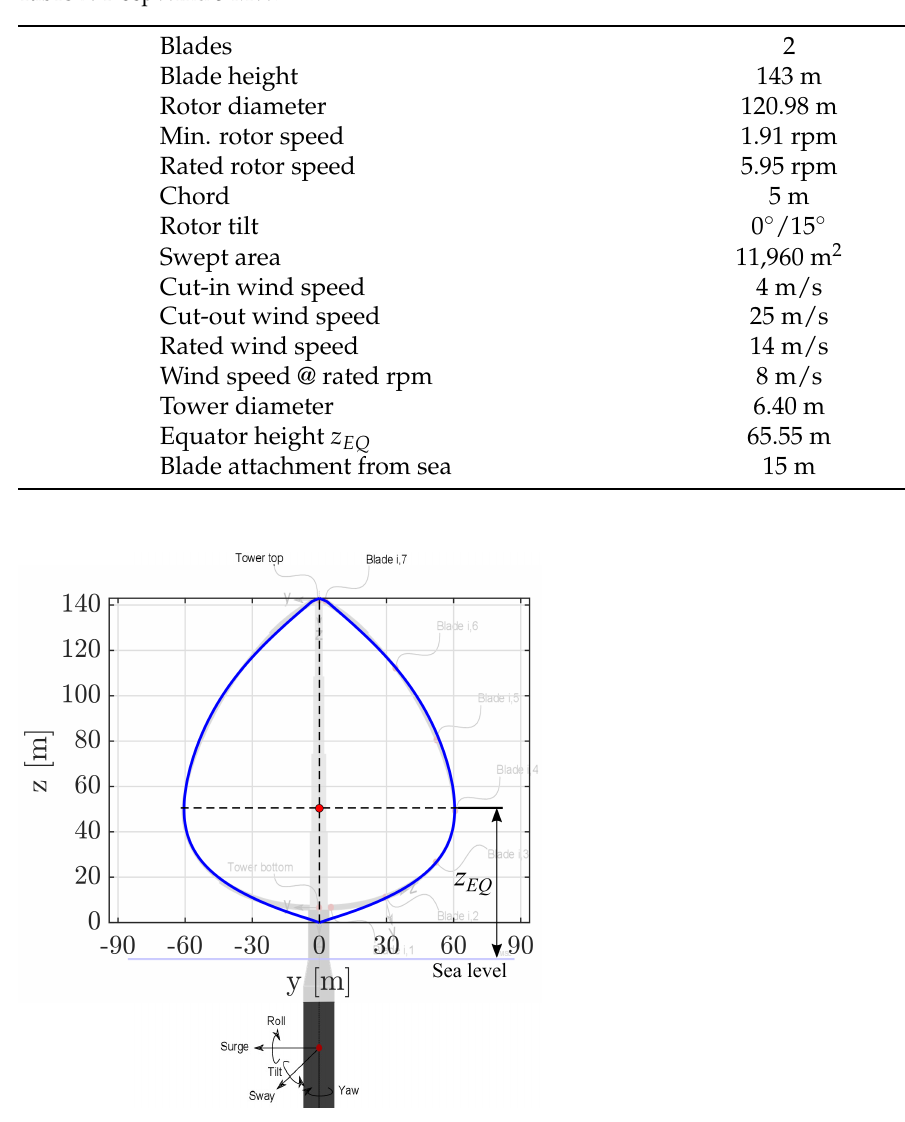
Figure 14. DeepWind 5 MW concept for FOWT